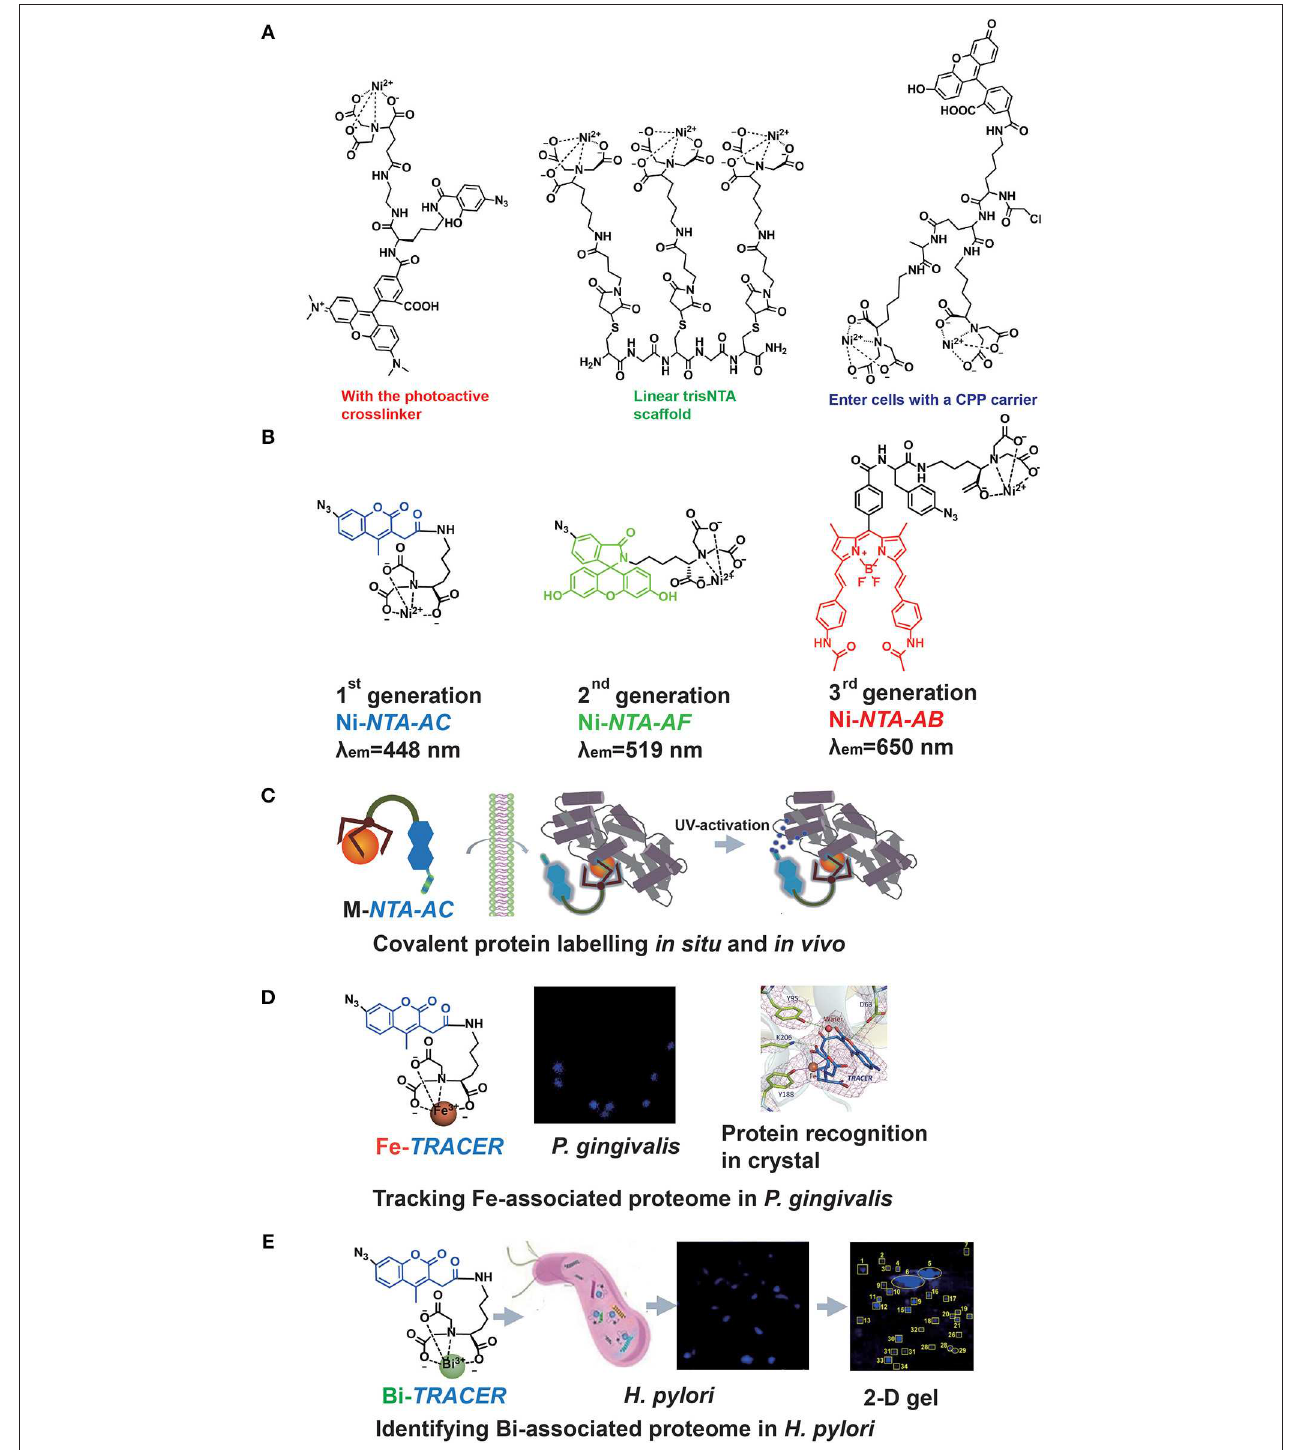
FIGURE 2 | The probe family based upon NTA-metal coordination with their applications in protein tracking. Typical Ni-NTA-based probes were presented in (A) whilst our three generations of homemade probes were listed as (B) , including Ni- NTA-AC , Ni- NTA-AF, and Ni- NTA-AB . Then the explorations for metal-associated proteomes in diverse system by using M- TRACER were presented as (C) the covalent labeling ability of M- TRACER toward intracellular proteins with UV-activation, (D) Fe-associated proteome tracked by Fe- TRACER in P. gingivalis and the protein-binding model released by X-ray crystallography, (E) Bi-associated proteome labeled by Bi- TRACER in H. pylori . (C,D) were reproduced from Jiang et al. (2018) with the permission of The Royal Society of Chemistry. (E) was reproduced from Wang et al. (2017) with the permission of The Royal Society of Chemistry.